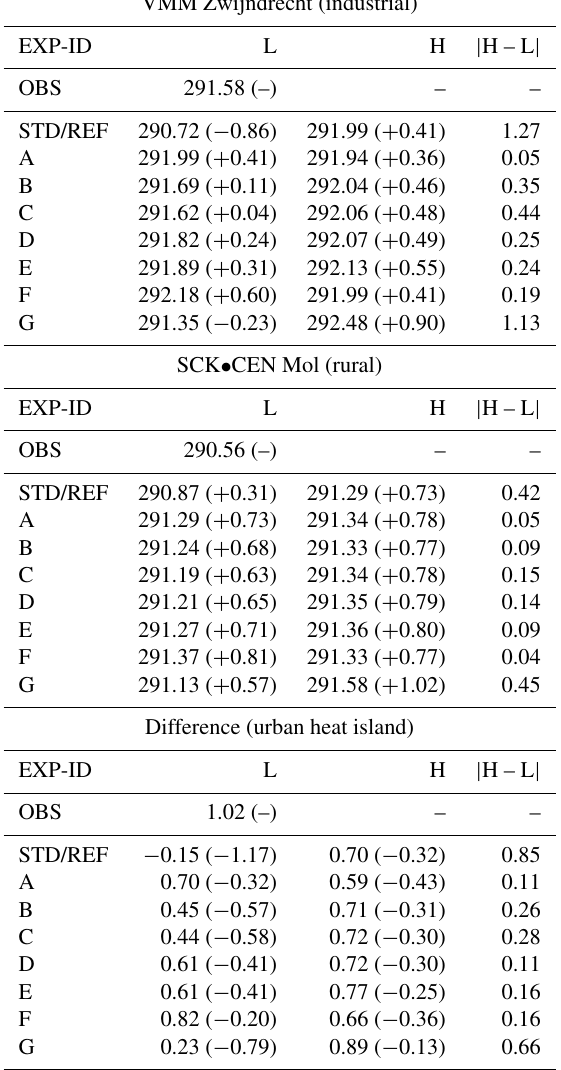
Table 6. Modelled and observed temperatures (in K) vertically av- eraged for the nocturnal (0h) tower profiles at the VMM indus- trial site in Zwijndrecht and at the SCK • CEN rural site in Mol. The values are averaged for the mid-summer period (21 July to 20 August 2012). Each first row shows results of the observa- tions. Each second row shows results for COSMO-CLM with- out urban parametrization (L column), for the COSMO-CLM us- ing TERRA_URB v2.0 (H column) and their absolute difference ( | H − L | column). The remainder rows show each of the urban- parameter sensitivity simulations in Table 2. Therefore, the low scenarios are shown in the L column, the high scenarios in the H column and the parameter sensitivity range (absolute difference be- tween L and H) in the | H − L | column.